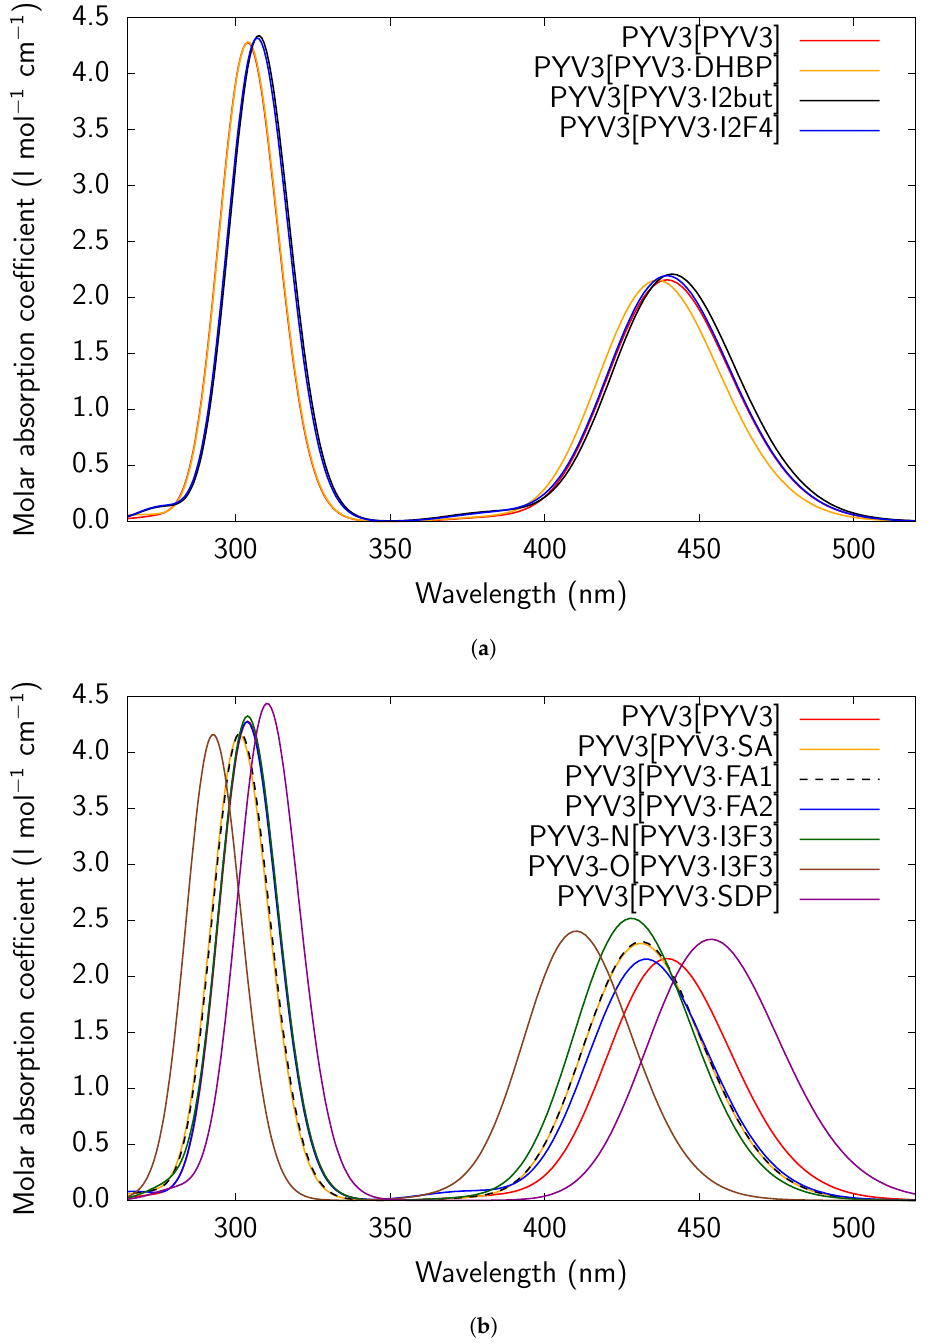
Figure 3. RI-CC2/def2-TZVPD UV/Vis absorption spectra of isolated monomers of all-keto crystals (PYV3 [PYV3 · XXX]). For clarity, the spectra have been splitted in two parts, see ( a ) and ( b